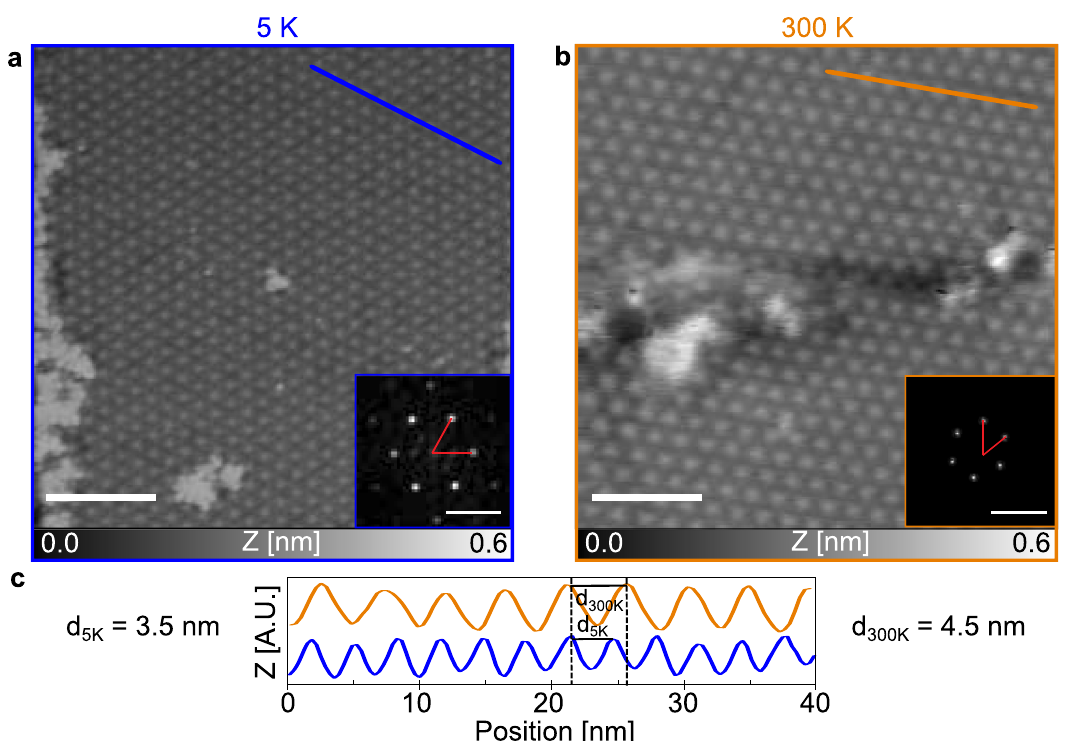
Fig. 2 Spoked wheel molecule assembly on Au(111). a Large scale STM topographic image of the assembly on Au(111) at 5 K. ( I = 1 pA, U tip = − 300 mV) b Large scale nc-AFM image of the assembly at 300 K. ( f 2 = 1.043 MHz, A 2 = 0.4 nm, Δ f 2 = − 19 Hz). c Line pro fi les acquired along the blue and orange lines in a , b showing a lattice parameter of 3.5 ± 0.1 nm and 4.5 ± 0.2 nm, respectively. The insets are fast Fourier transform (FFT) of the images. Scale bars: topographies: 20 nm; FFT: 0.5 nm − 1